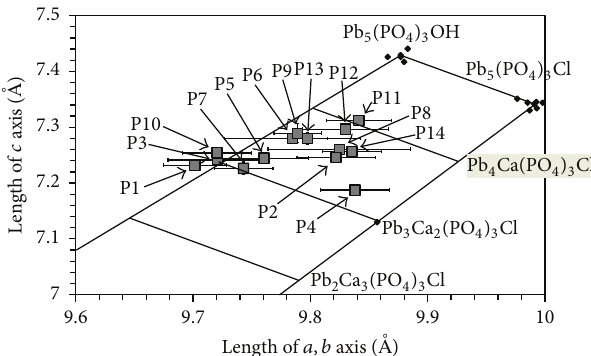
Figure 3: Unit cell graph for apatites from lead water pipes.